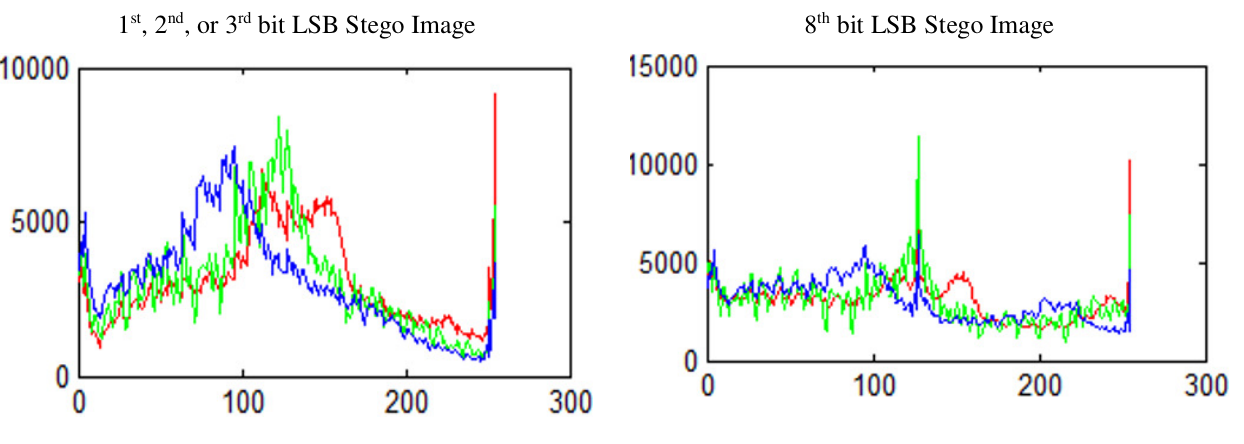
Fig. 5. Evaluation results for hidden secret color image of (98.3